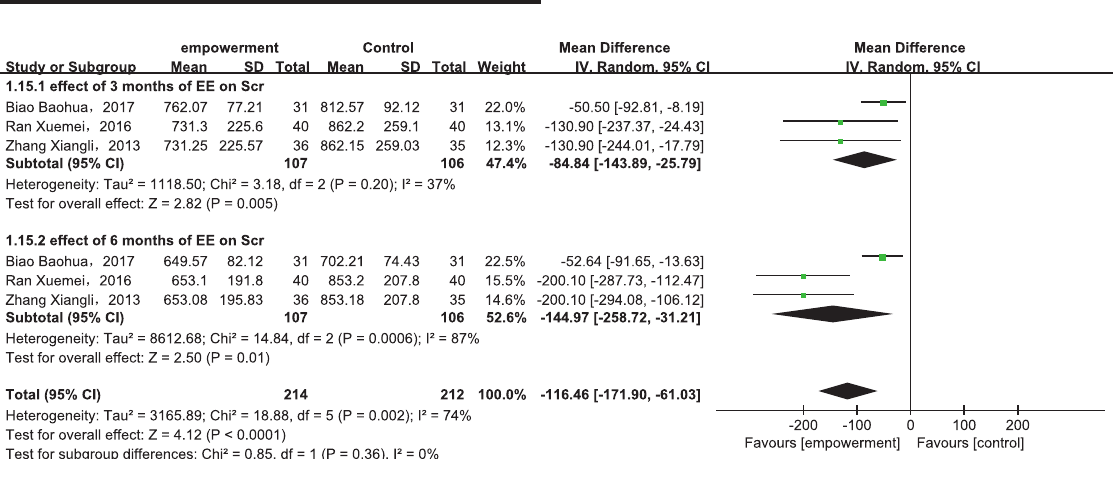
Figure 8. Comparison of serum creatinine between empowerment education intervention group and traditional education